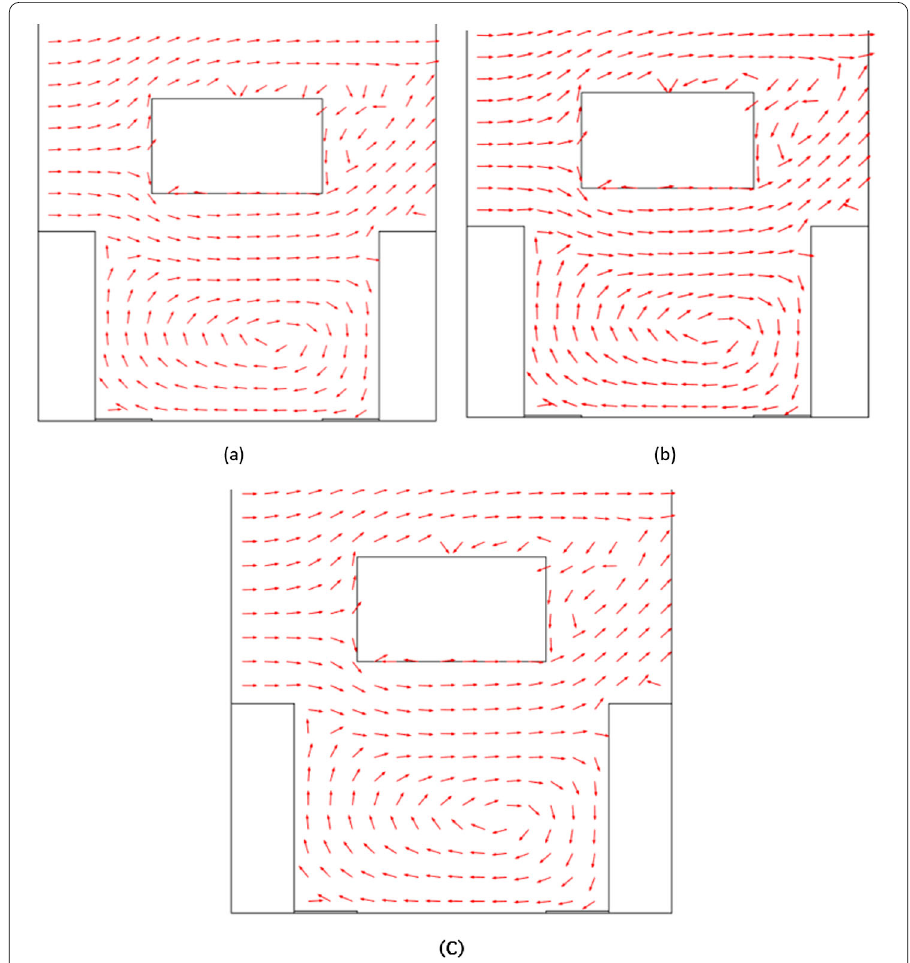
Figure 11 The velocity vector (km/h) at steady state state of the zoom-in selected area: ( a ) u = 7 km/h (gentle wind), ( b ) u = 18 km/h (moderate wind), and ( c ) u = 25 km/h (strong